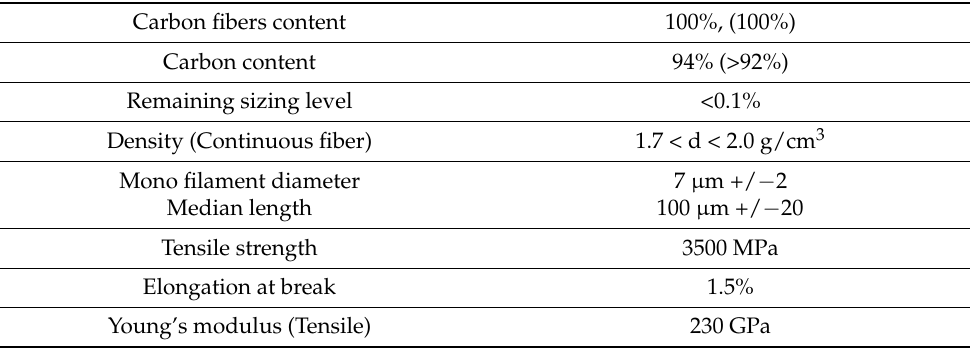
Table 2. Properties of the carbon fibers (given by the